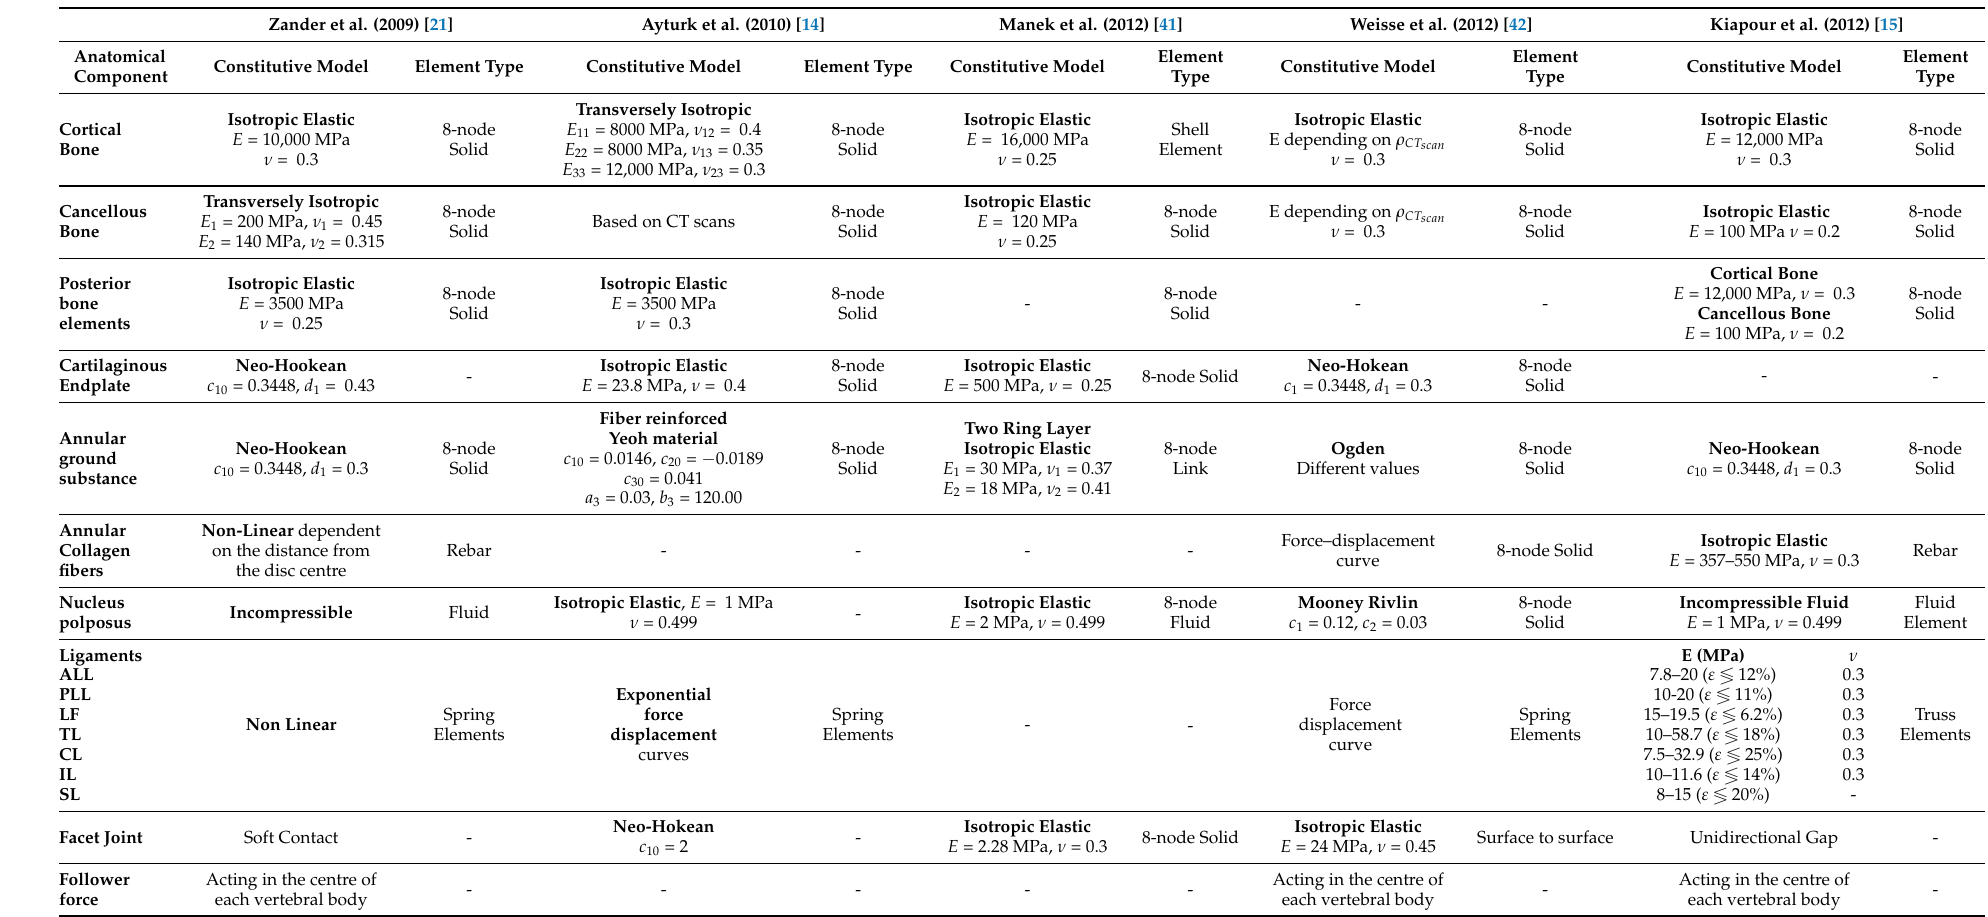
Table A2. The main information extracted from